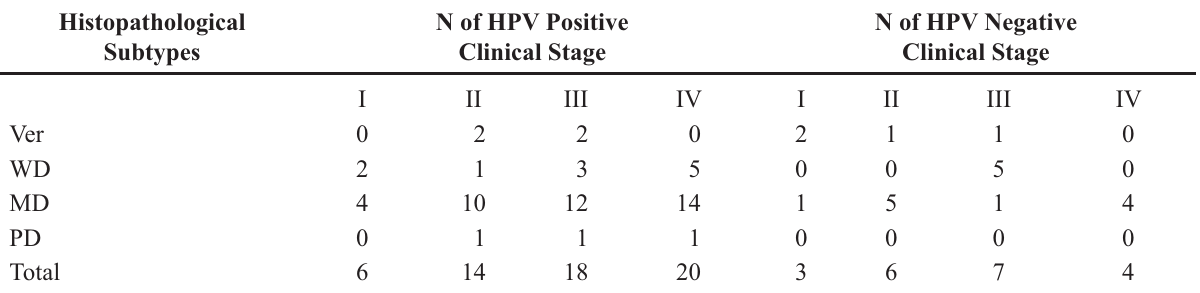
Table 2 – HPV DNA positive and negative penile cancer according to the histopathological subtypes and clinical